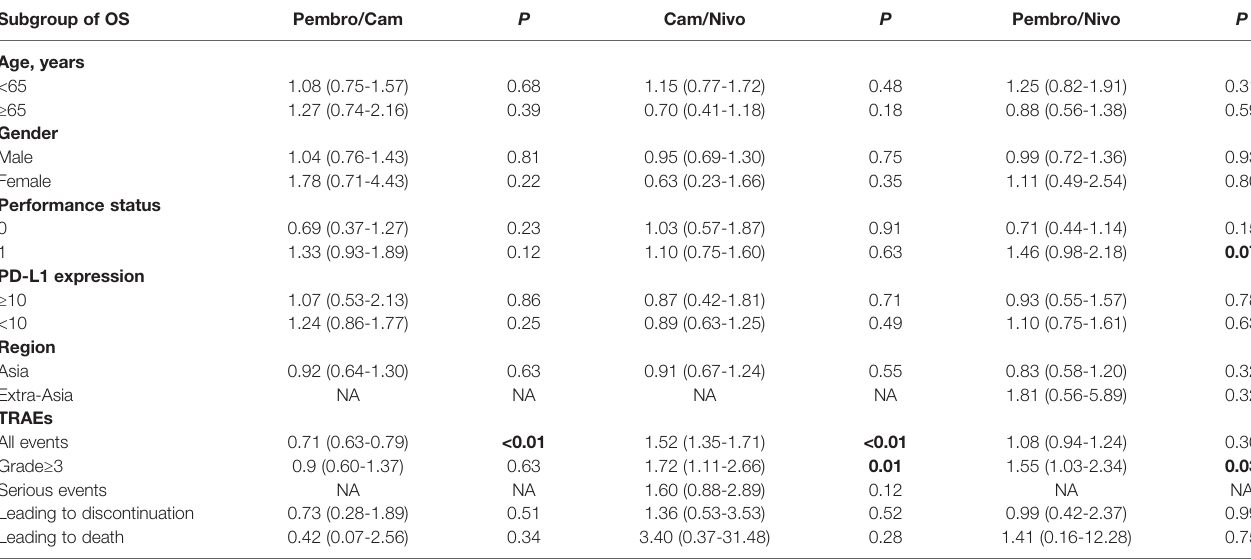
TABLE 2 | Indirect comparisons among pembrolizumab, nivolumab, and camrelizumab in terms of prede fi ned subgroup of OS and treatment-related adverse events. Subgroup of